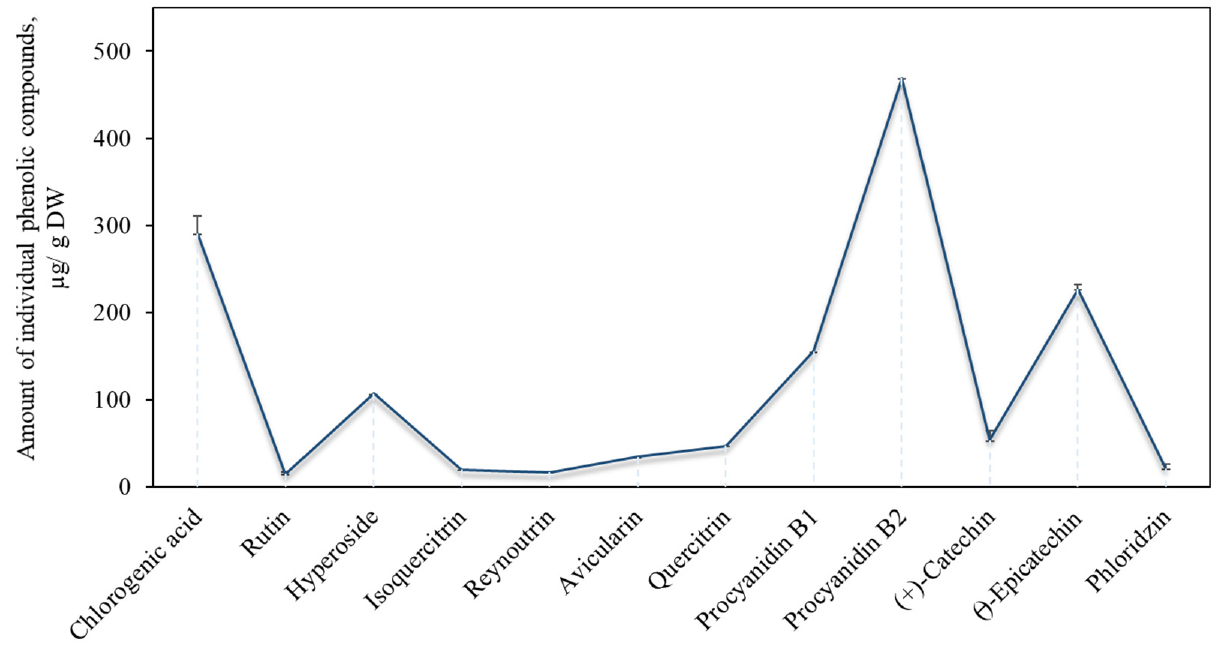
Figure 1. Content of chlorogenic acid, flavonols, flavan-3-ols and phloridzin.